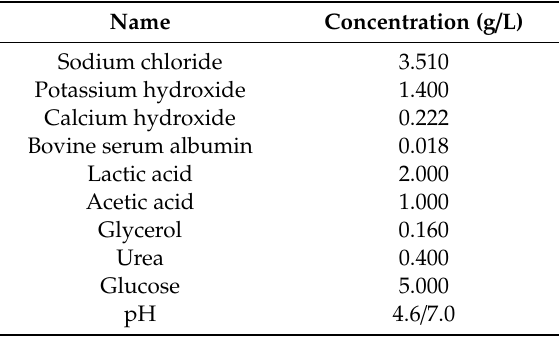
Table 1. Composition of simulated vaginal fluid